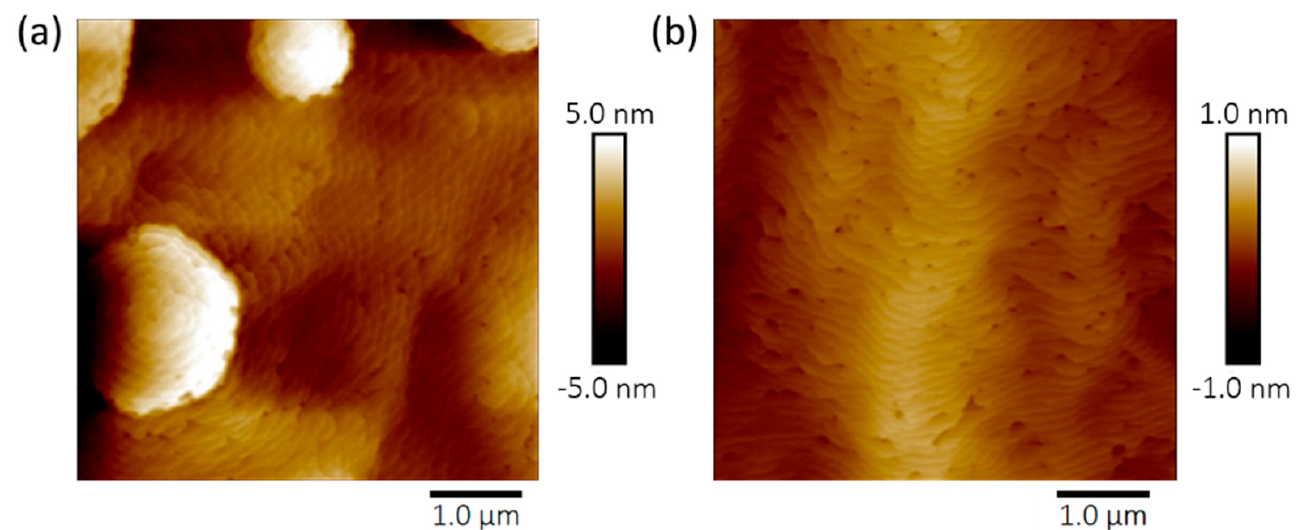
Figure 2. 5 × 5 µm 2 AFM images of AlGaN grown at 1155 °C ( a ) on 10 × 10 µm 2 tiles of compliant pseudo-substrate; ( b ) on planar GaN, with image taken in the region in between cracks which developed due to strain.